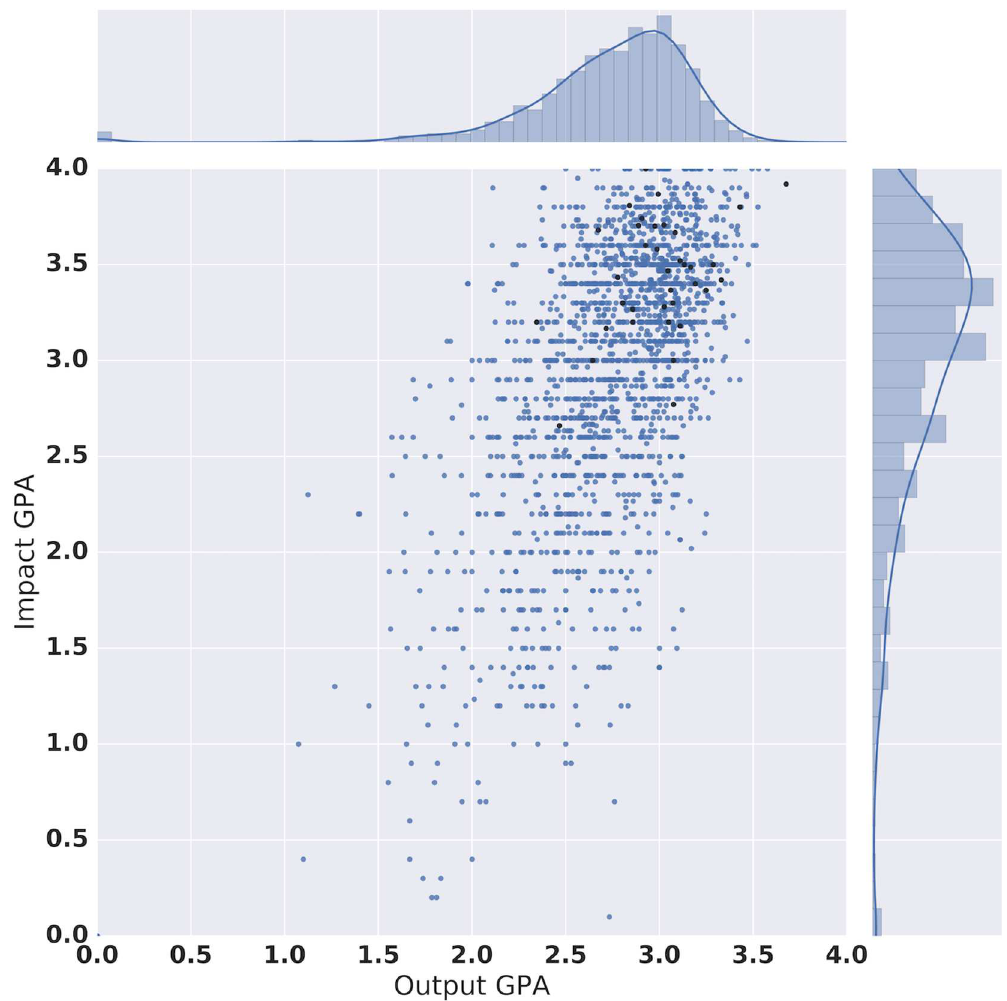
Fig 2. Impact GPA as a function of Output GPA for each Unit of Assessment in REF2014. Sector data is shown in blue, UCL contributions are shown in black. Marginaldistributions show the positive skew of the data (Output Median= 2.82, Impact Median =